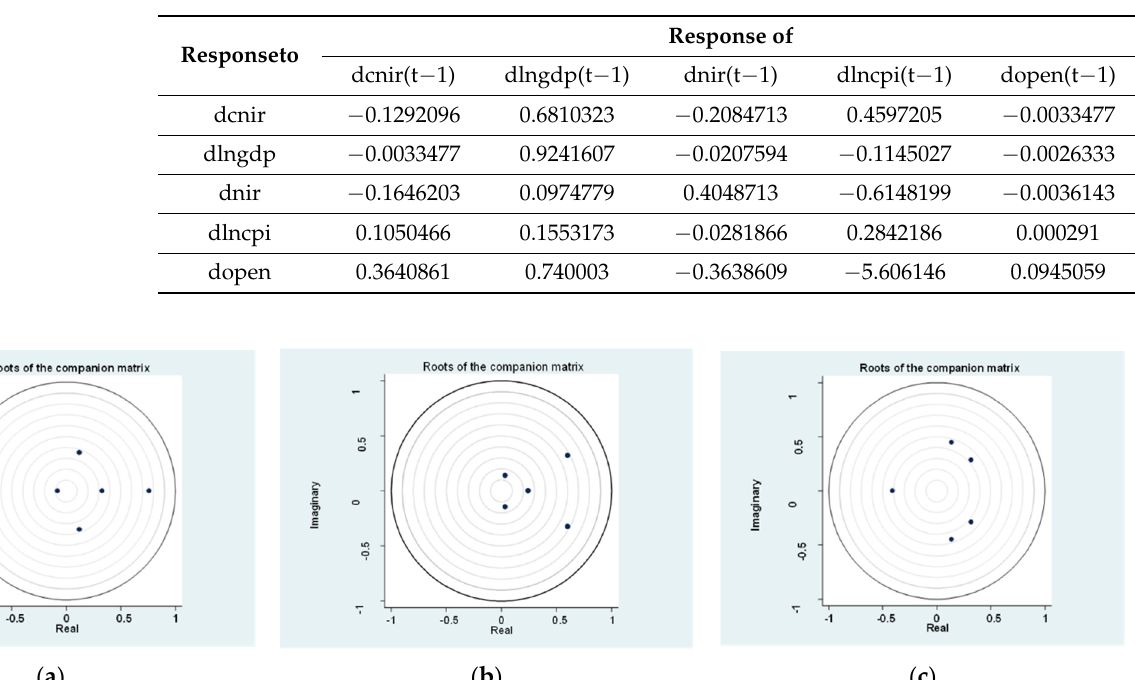
Table 5. Moment and Model Selection Criteria (MMSC) for Trade Shock.